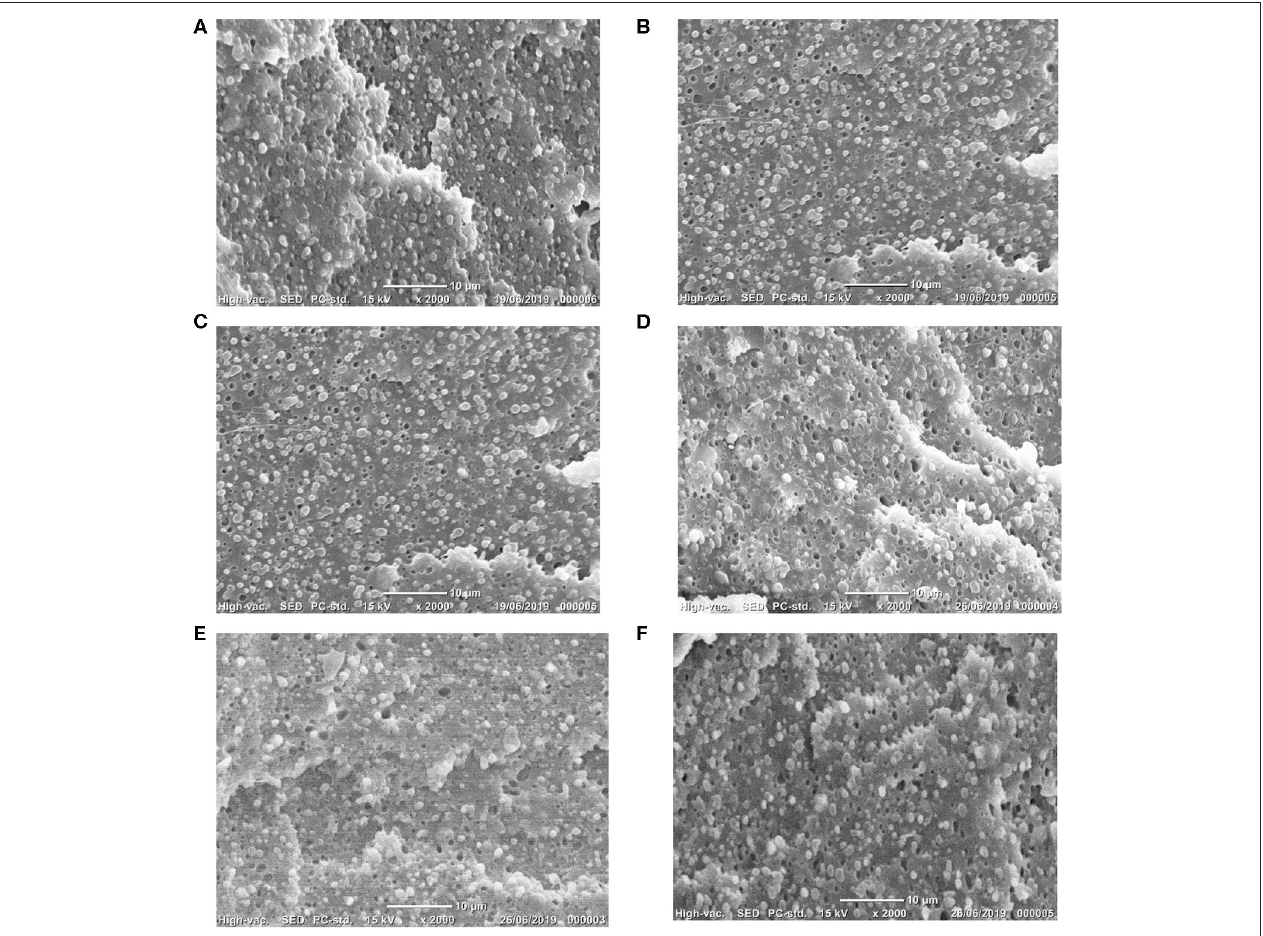
FIGURE 6 | Cross-sectional SEM analysis of injection-molded PLA/PA12/PLA-g-MA blends (A) 70/30/0, (B) 69/30/1, (C) 68/30/2, (D) 67/30/3, (E) 66/30/4, and (F)